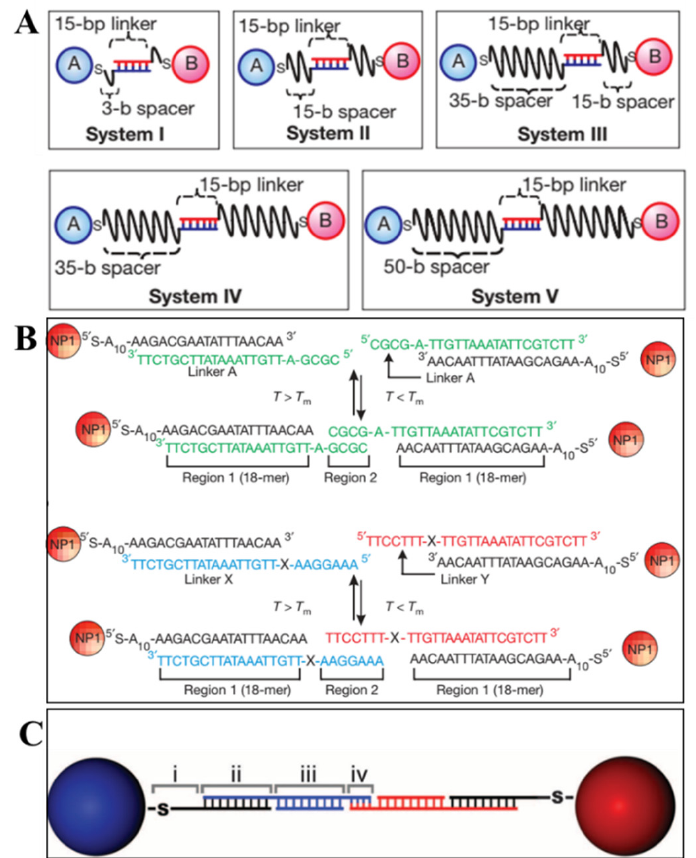
Figure 3. SsDNA linkages between NPs. ( A ) Connection by two linkers on the surface of NPs (System I to V: different spacers in length) (Adapted with permission from [7]. Copyright 2008, Springer Nature.); ( B ) connection by a free linker including a flexor region (X region) (Adapted with permission from [6]. Copyright 2008, Springer Nature.); ( C ) polyvalent conjugates of DNA and AuNPs by four free linkers. (Adapted with permission from [8]. Copyright 2011, American Association for the Advancement of Science.).